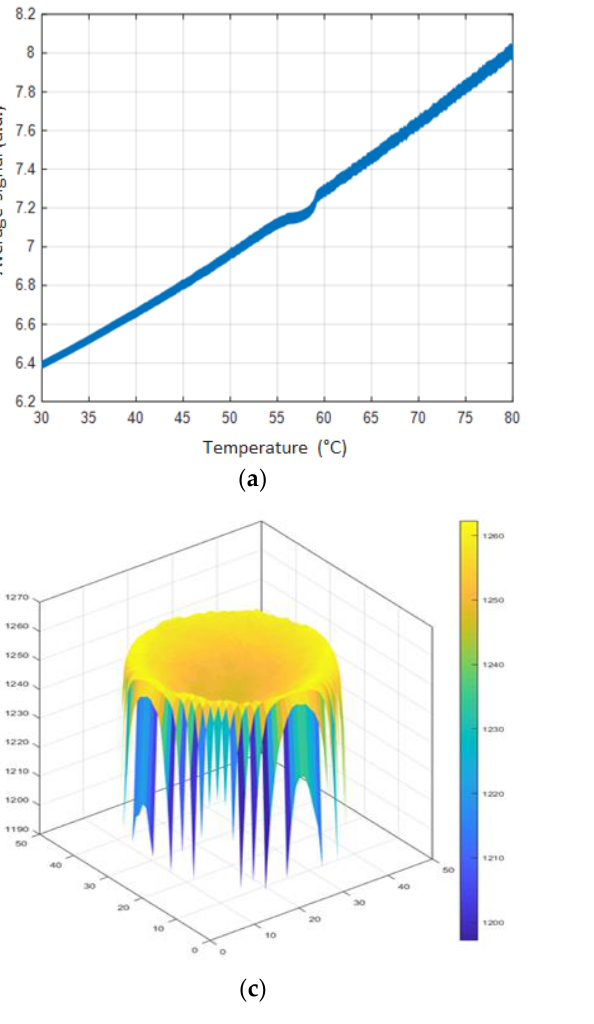
Figure 2. ( a ) Case 1: Infrared signal averaged on all the pixels of a sample; ( b ) Case 2: Infrared signal of each pixel of a sample; ( c ) Signal distribution inside an example sample of Myristic acid; ( d ) Case 3: Infrared signal of each pixel of a sample, excluding outliers from the signal distribution. Table 2. Melting temperatures and enthalpies obtained with DSC measurements, as stated in the literature [23,33,35,37,42–45] and estimated with IRT for six eutectic samples of fatty